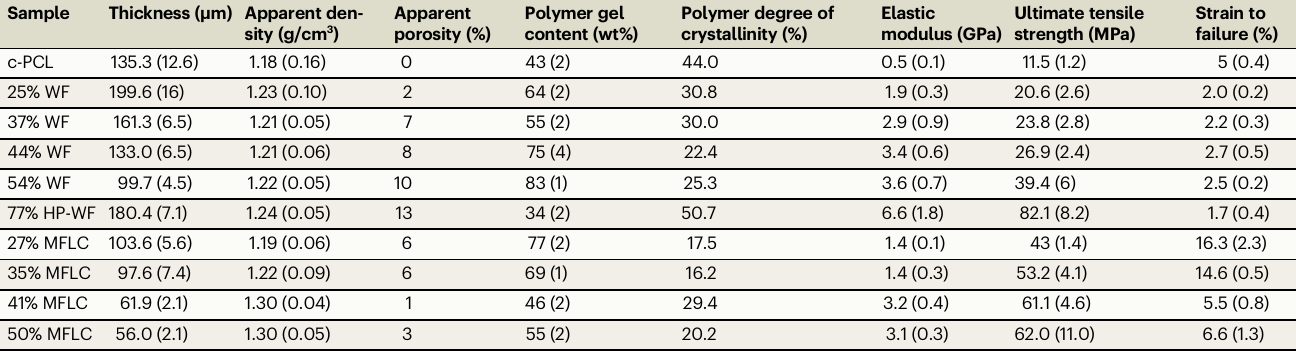
Table 1 | Summary of physical and mechanical properties of WF and MFLC biocomposites Sample Thickness ( μ m) Apparent den-